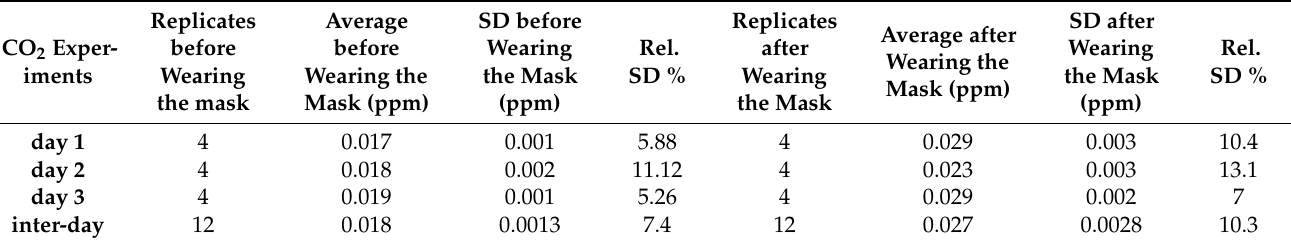
Table 3. Intra- and inter-day repeatability: ethylene